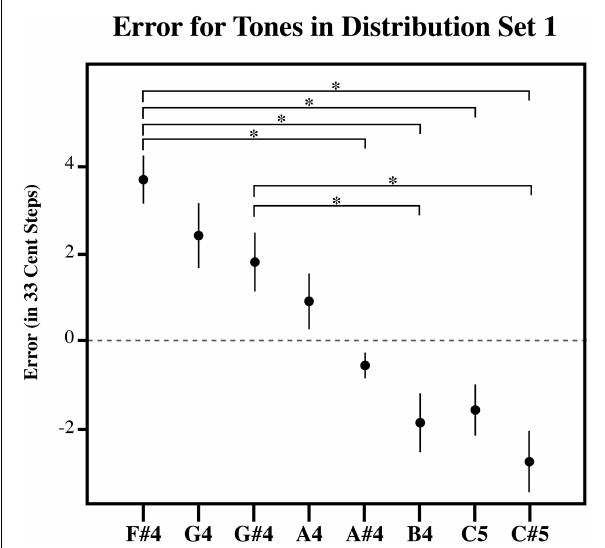
FIGURE 4 | The plot of the estimation error in 33-cent steps for each tone in Distribution Set 2. Significant pairwise comparisons (alpha 0.05) using a Sidak adjustment are indicated with an asterisk. Note that while individuals bisected the presented distribution at its midpoint, such that lower target tones in the series are overestimated and higher target tones in the series are underestimated similar to the randomly generated tone estimate data, individuals produced estimates that were significantly more accurate than the RGD ( Figure 6B ). Error bars represent ± 1